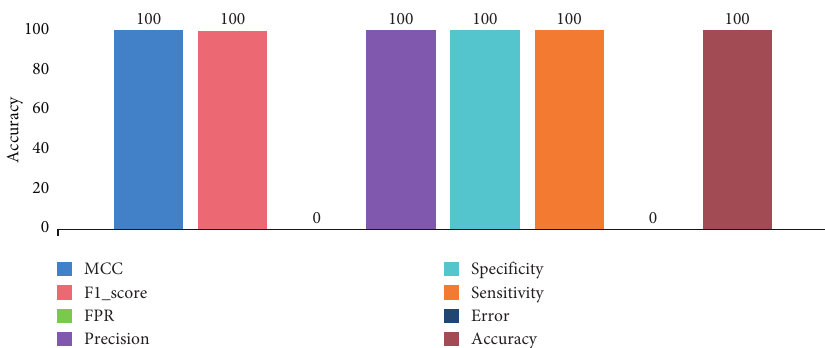
Figure 5: Overall, the values of COVID-19 with normal cases.